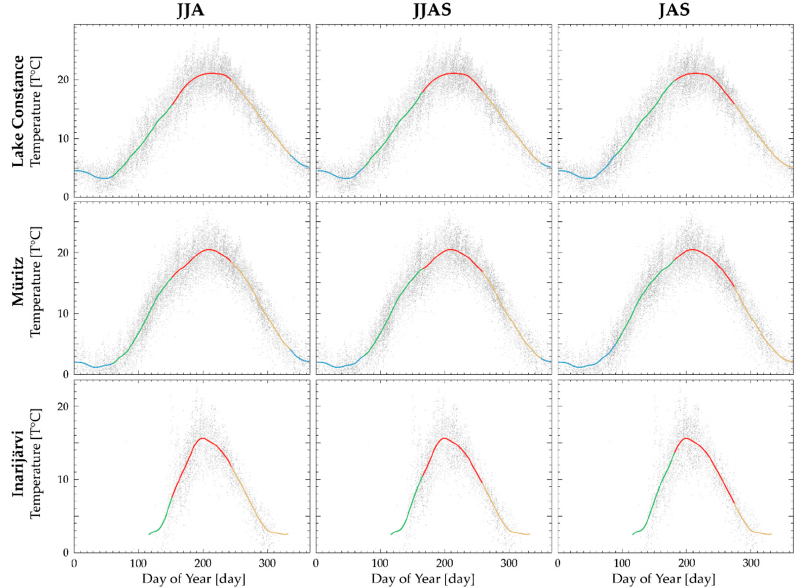
Figure 5. Comparison for different season periods (JJA, JJAS, JAS) in the yearly temperature cycle at lake Constance, Müritz, and Lake Inari. The middle row, representing the seasonal periods as used during this study is well adapted to the actual annual cycles, as the summer temperature peak is in the center of the period.